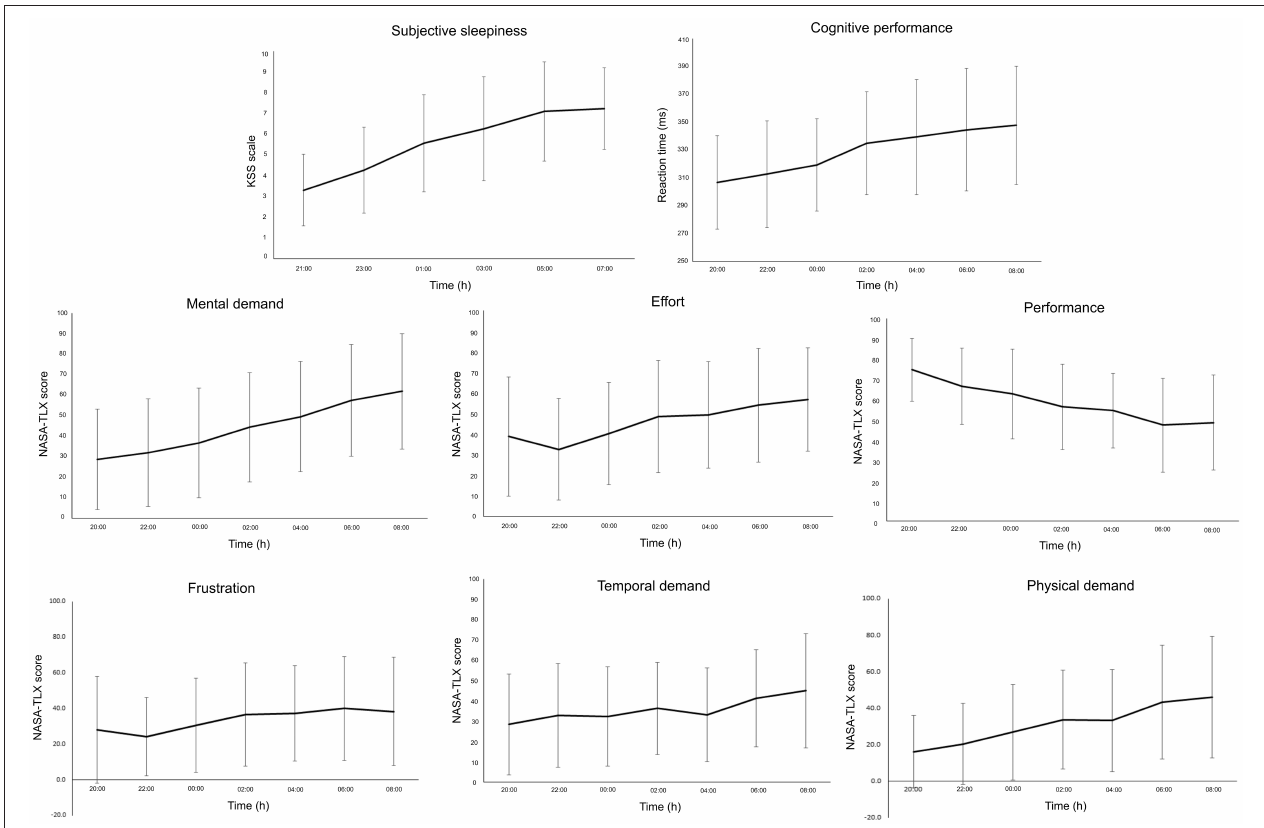
FIGURE 2 | Mean and standard deviation of subjective sleepiness [Karolinksa Sleepiness Scale (KSS)], cognitive performance (psychomotor vigilance task), and subjective workload [National Aeronautics and Space Administration Task Load Index (NASA-TLX)] for each subscale (Mental Demand, Effort, Performance, Frustration, Temporal Demand, Physical Demand) during the overnight assessments (from 20:00 to 08:00h).